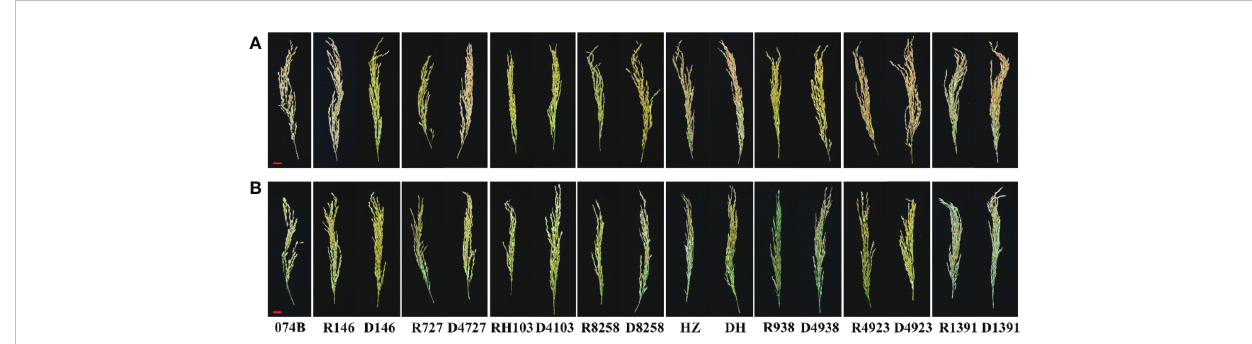
FIGURE 1 Rice panicles of progeny and restorer lines. (A) Panicles under control conditions. (B) Panicles under drought treatment conditions. Bar = 2